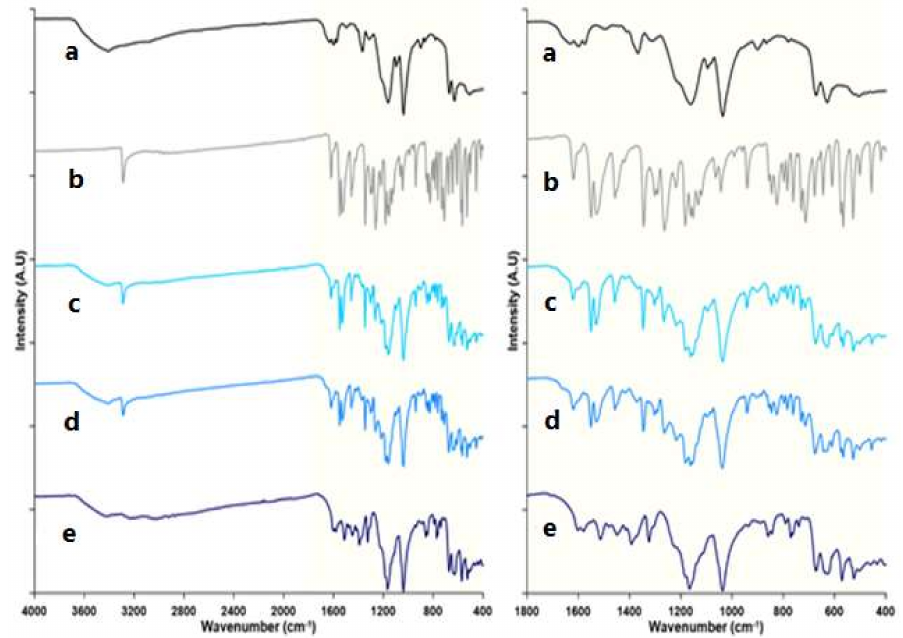
Figure 5. FTIR spectra of following: ( a ) sulfonatocalix[4]naphthalene (C), ( b ) meloxicam (ME), ( c ) physical mixture (PM), ( d ) kneaded (KN), and ( e ) coevaporate (CO)